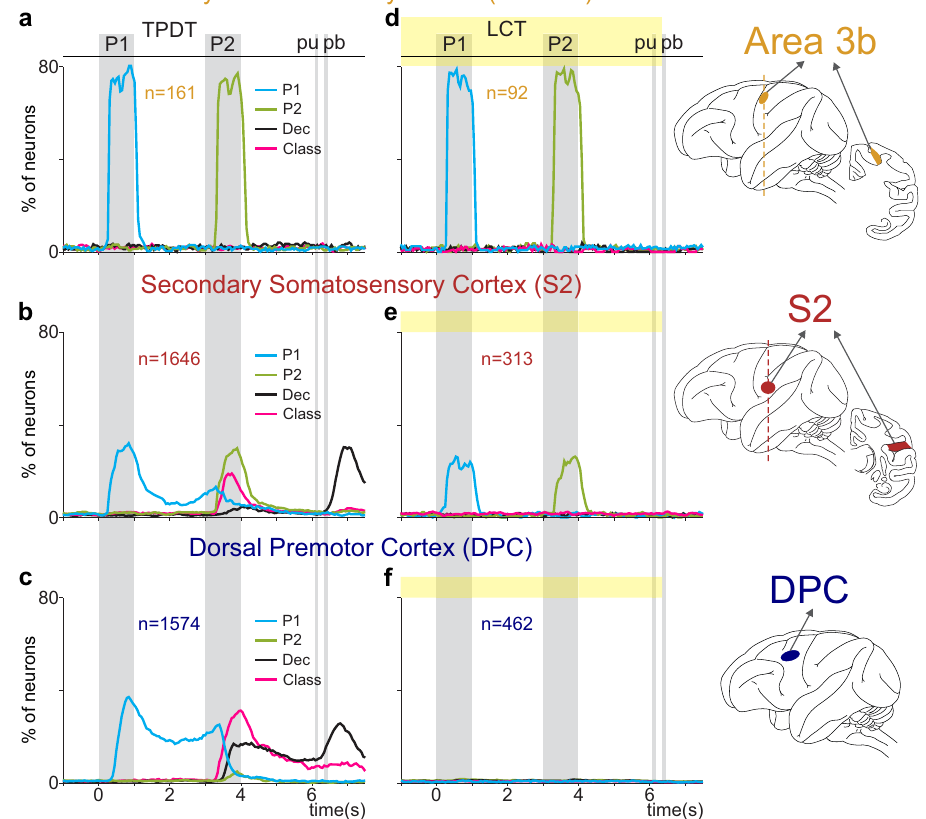
Fig. 7 Population coding dynamics across the cortex during the TPDT vs. the LCT. Percentage of neurons with signi fi cant coding (Supplementary Fig. 3) as a function of time during the TPDT (right, a – c ) or the LCT (left, d – f ). Traces refer to P1 (cyan), P2 (green), class (pink), and decision coding (black). Neurons were recorded from different cortical areas: Area 3b (TPDT [ a , n = 161] and LCT [ d , n = 92]), S2 (TPDT [ b , n = 1646] and LCT [ e , 313]), and DPC (TPDT [ c , n = 1574] and LCT [ f , n = 462]). Note that area 3b is included in the primary somatosensory cortex (S1). The same y -axis scale (0 to 80%) was used across panels to facilitate comparison. Area 3b demonstrates an entire network commitment to representing stimulus. In S2, the sensory representation diminishes and the categorical representation emerges. The emergent categorical representation is, in turn, the only activity code observed for